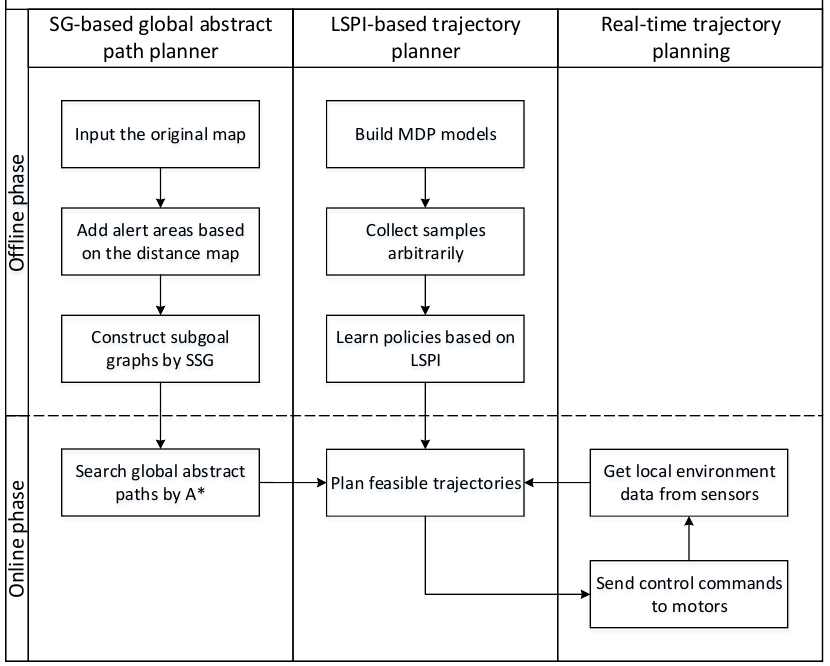
Figure 2. Subgoal graphs–reinforcement learning (SG–RL) flowchart.